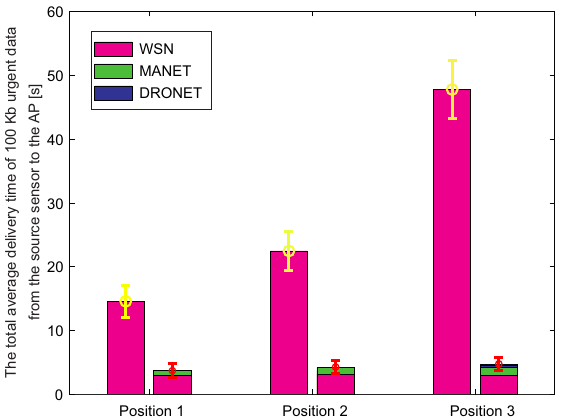
Figure 22. The total average delivery time of 100 Kb urgent data from the source sensor to the